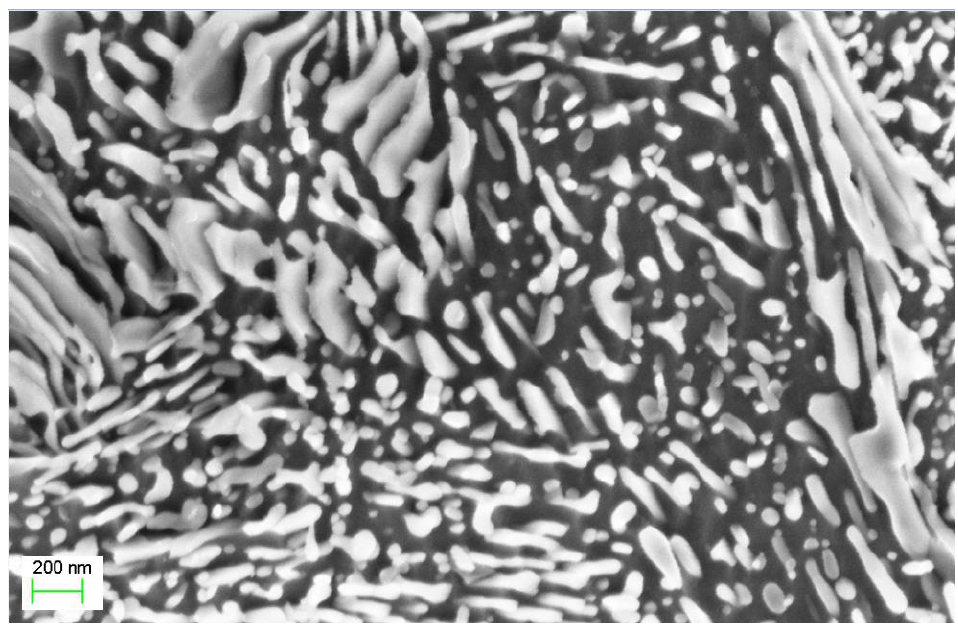
Figure 5. An SEM image shows the anisotropic fracture of the cementite plates in electropulse- induced recrystallisation of pearlite steels.